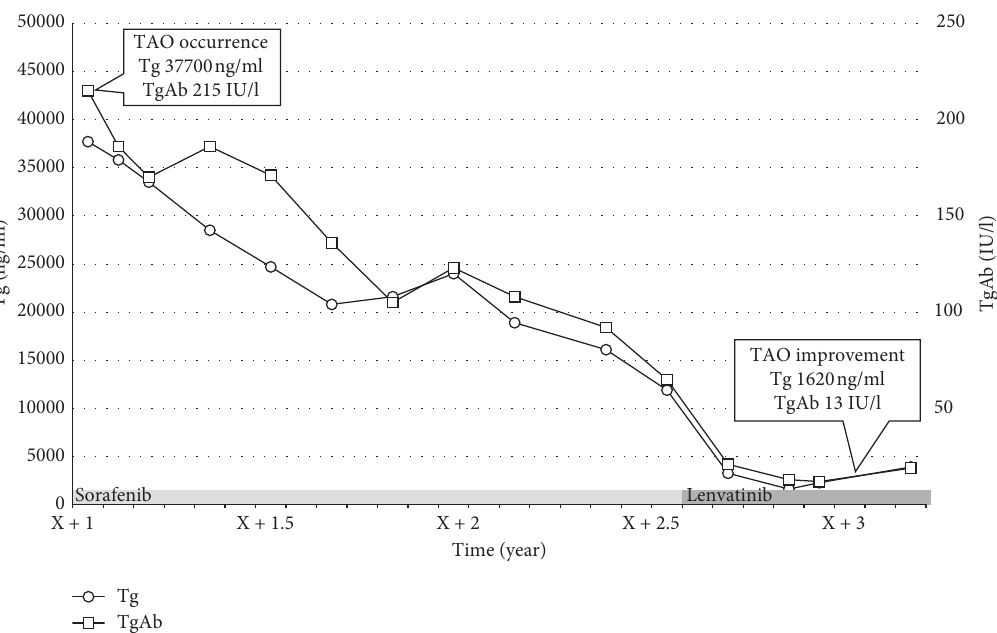
Figure 5: Change of thyroglobulin (Tg) and thyroglobulin antibody (TgAb) levels (from thyroid-associated ophthalmopathy occurrence to